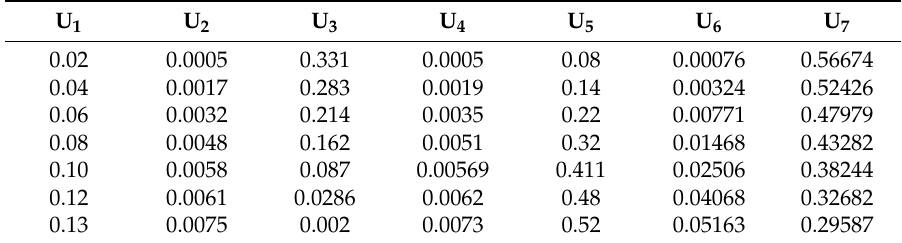
Table 2. Volume fractions of all